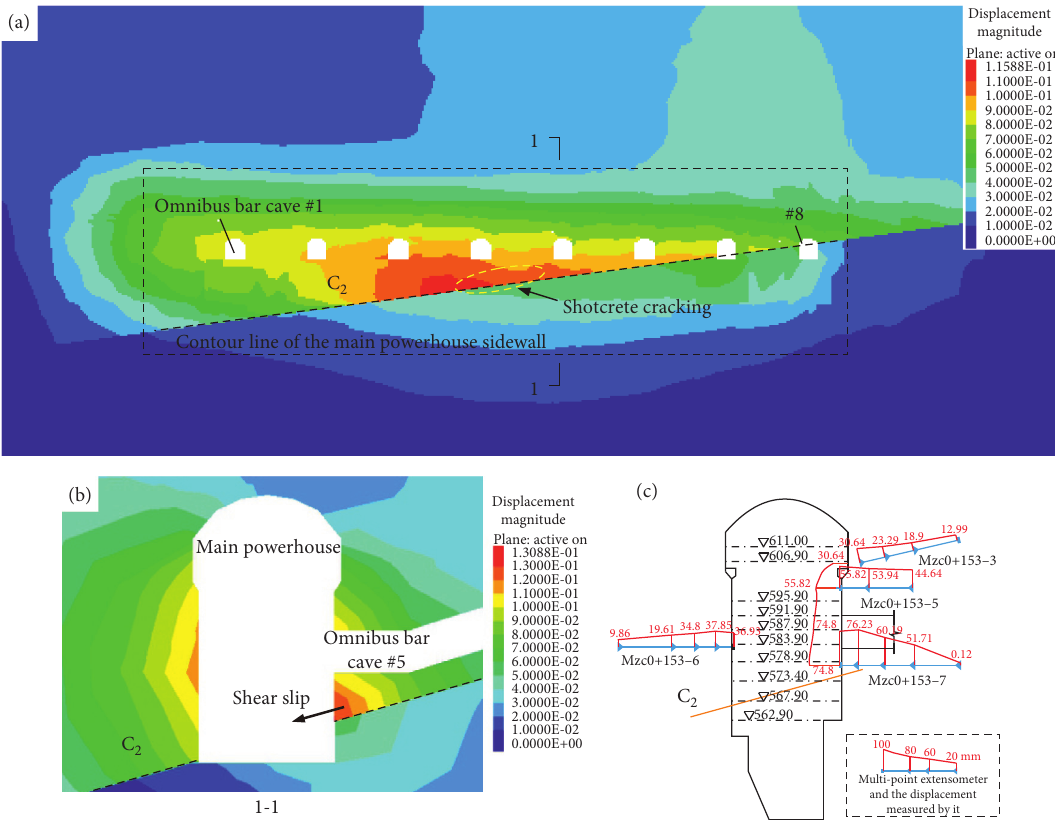
Figure 11: The deformation results of the 3DEC simulation calculation and the deformation measured by the multipoint extensometers: (a) the deformation distribution along the axis direction of the main powerhouse calculated by 3DEC software; (b) the deformation distribution along the ZC0+153 m section calculated by 3DEC software; (c) the displacement distribution of the ZC0 +153m section measured by the multipoint extensometers in January